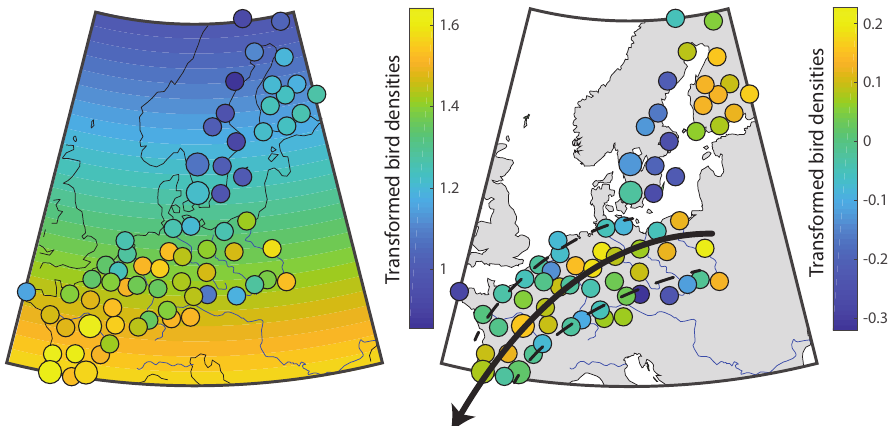
Figure A3. Fitted trend with averaged observations at radar location ( left ) and detrended data ( right ).